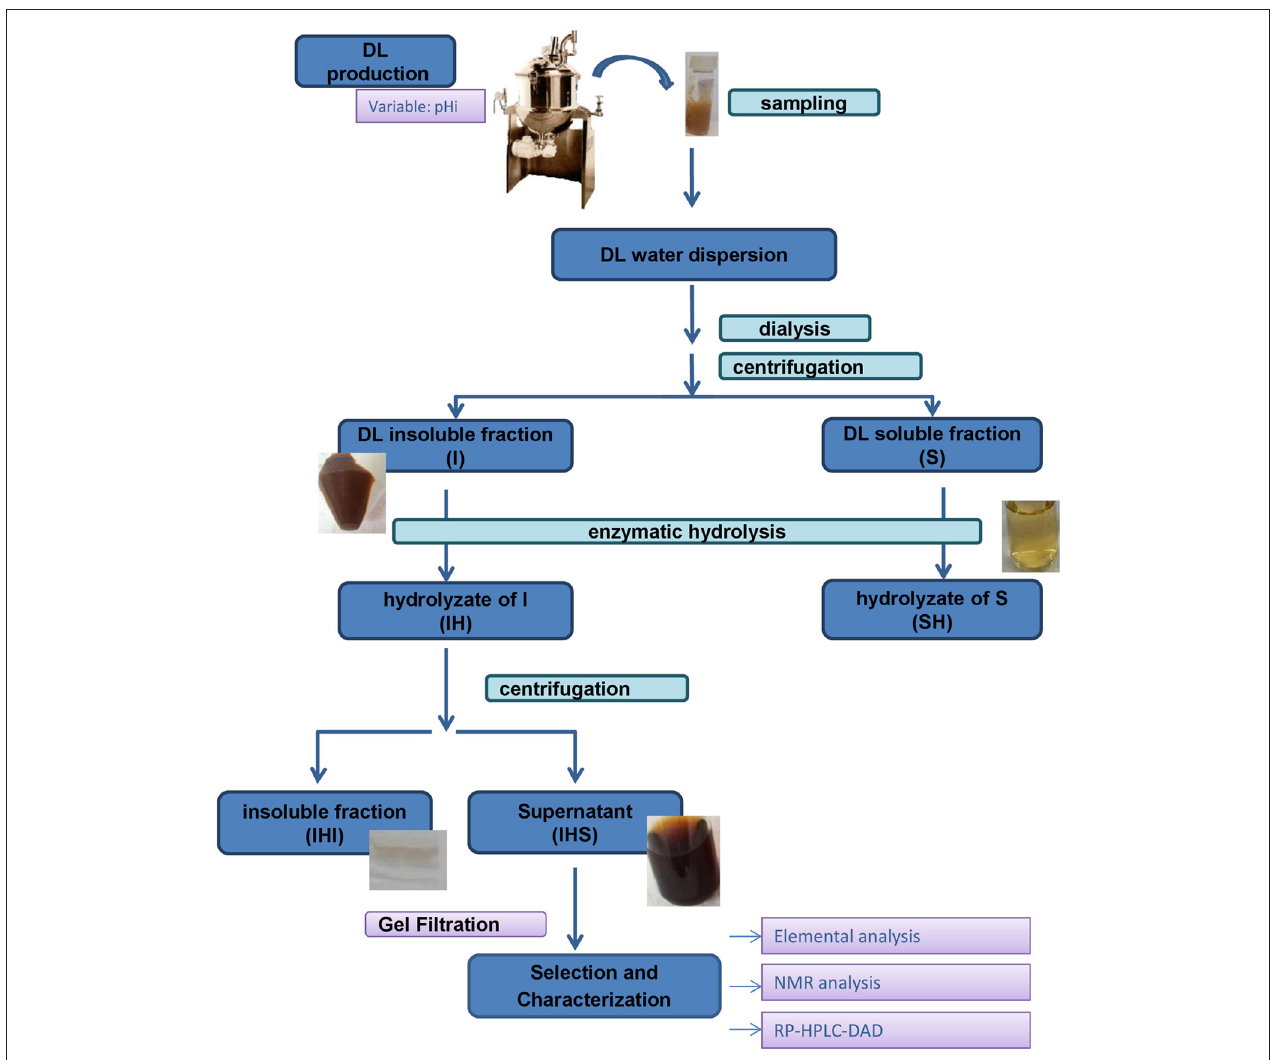
FIGURE 1 | Schematic representation of the isolation and fractionation of DL